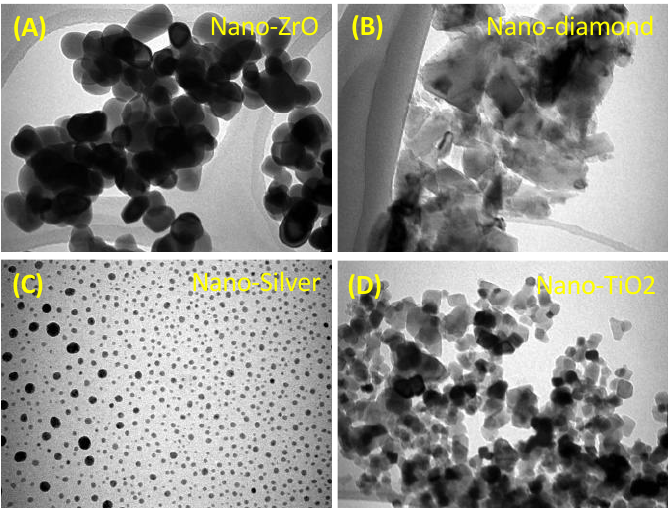
Figure 4. Transmission Electron Microscopy (TEM) images of different inorganic nanoparticles that could be incorporated into denture base resin to impart bioactivity and antimicrobial properties: ( A ) Nano-Zirconium Oxide; ( B ) Nano-diamond; ( C ) Nano-Silver; and ( D ) Nano-Titanium Dioxide nanoparticles.